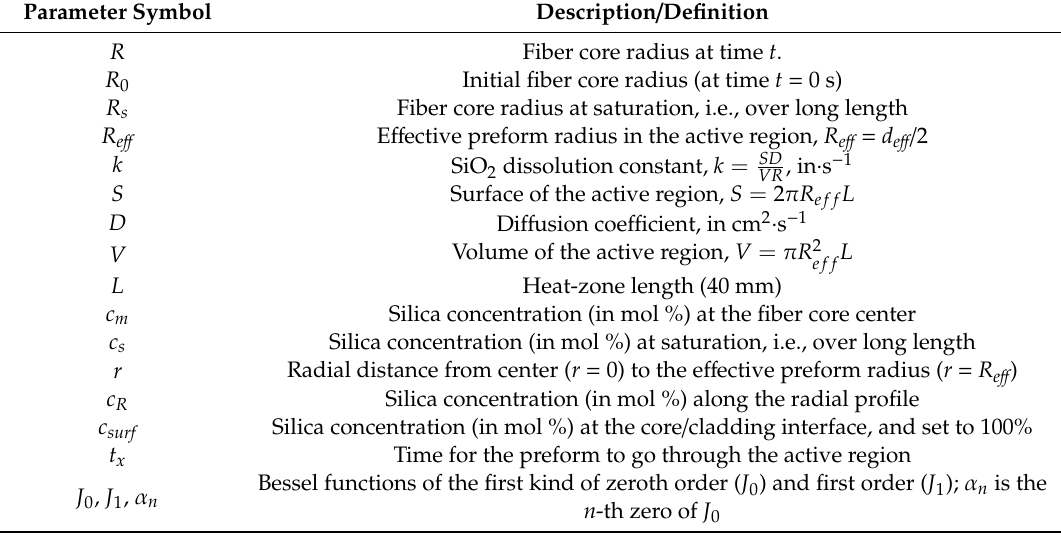
Table 3. Parameters used during modeling and their associated meaning /